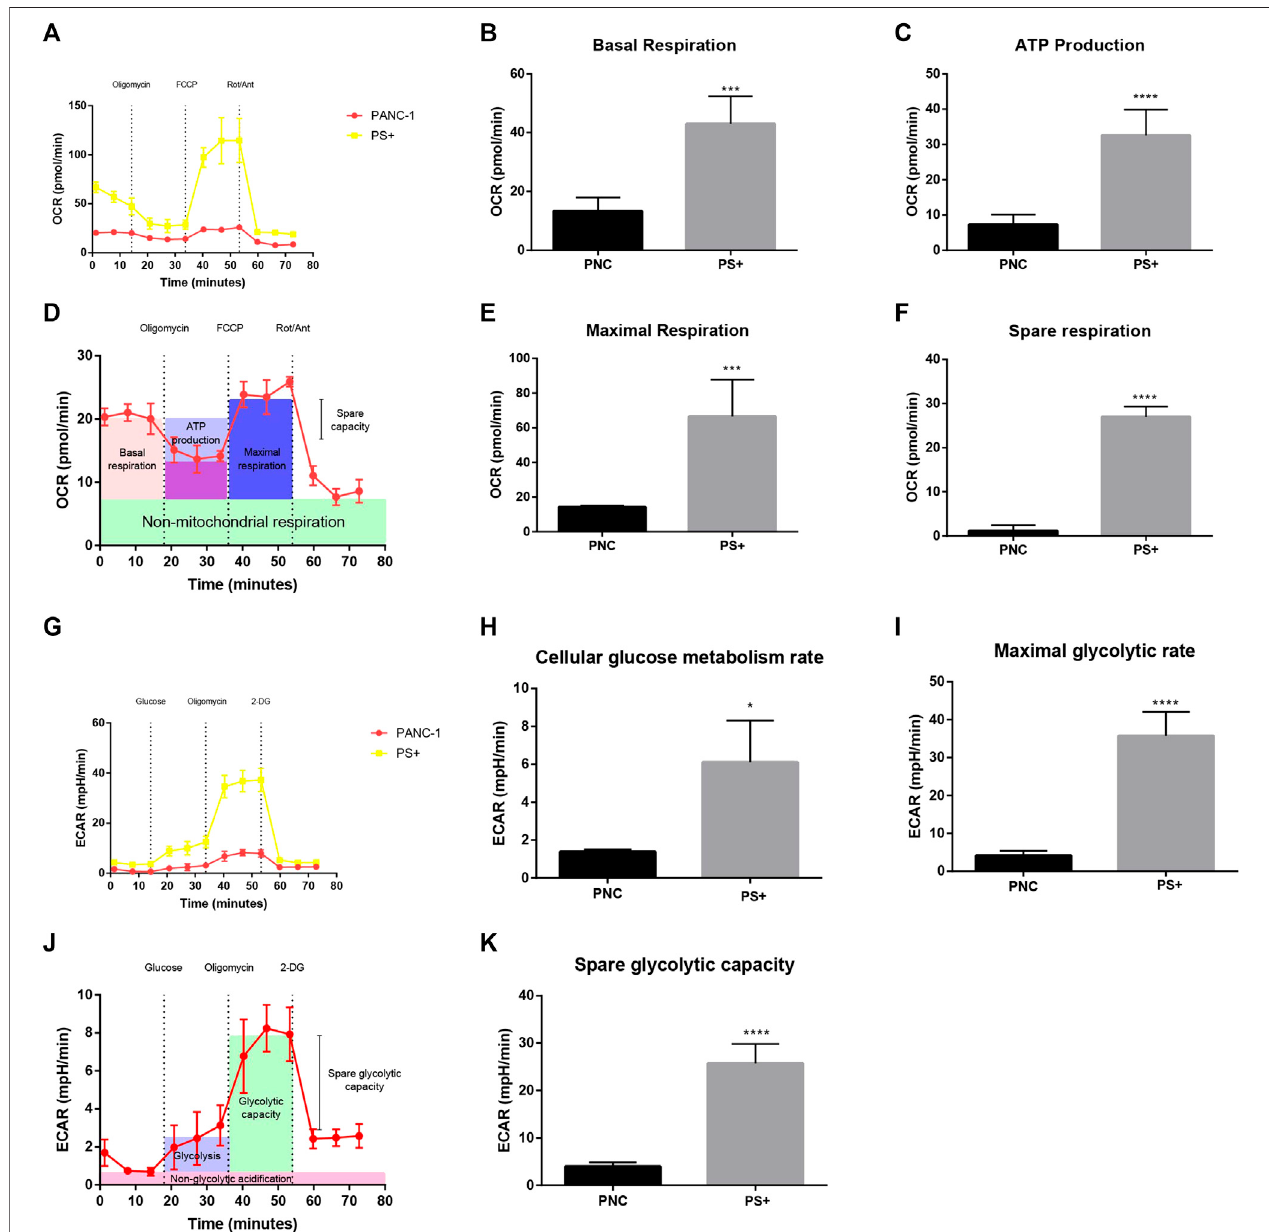
FIGURE6| Sestrin2overexpressionpromotesglycolysisinPANC-1cells. (A) OCRassay.Sestrin2overexpressionornotofPANC-1cellswereincubatedfor24 h. (B) Statistical bar chart of the basal respiration. (C) Statistical bar chart of the ATP production. (D) Schema chart of OCR. (E) Statistical bar chart of the maximal respiration. (F) Statistical bar chart of the spare respiration. (G) ECAR assay. Sestrin2 overexpression or not of PANC-1 cells were incubated for 24 h. (H) Statistical bar chart of the cellular glucose metabolism rate. (I) Statistical bar chart of the maximal glycolytic rate. (J) Schema chart of ECAR. (K) Statistical bar chart of the